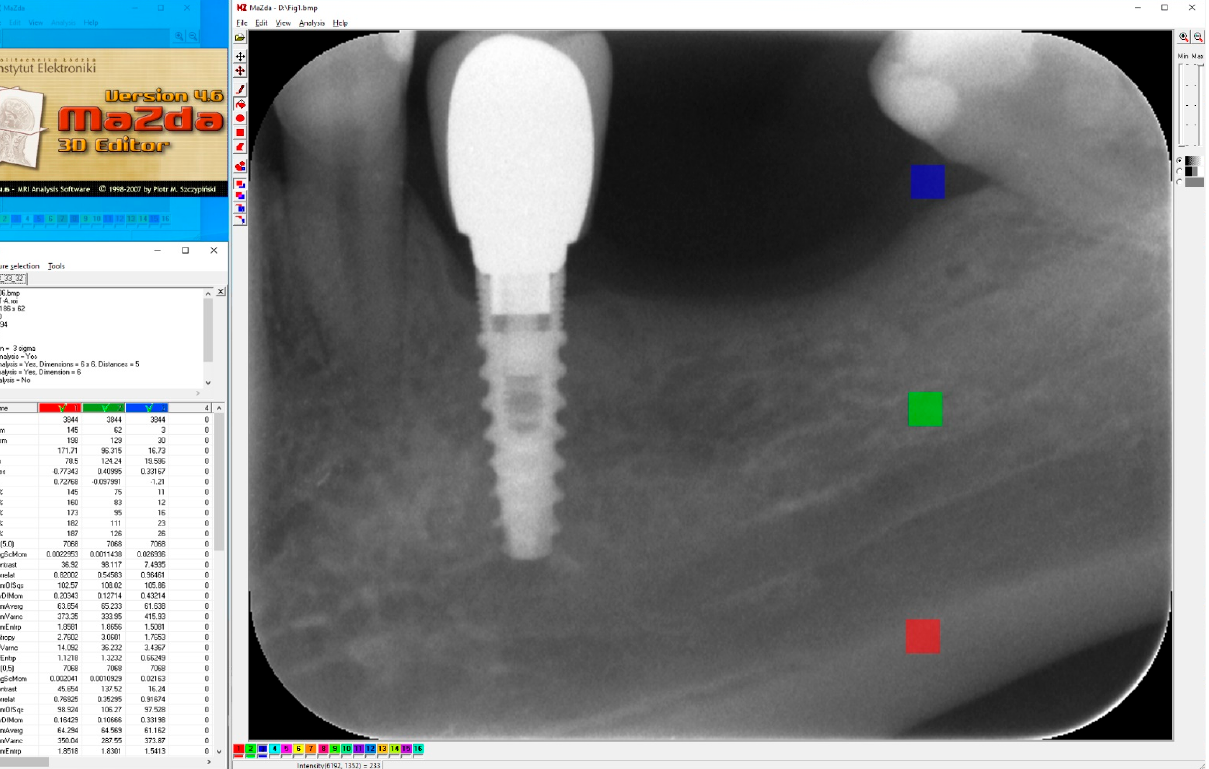
Figure 1. Regions of interest were located in cortical bone (ROI 1), trabecular bone (ROI 2) and soft tissue (ROI 3) in main window of MaZda. Next, a series of textural features was extracted (MZ Reports—on the left) and exported in comma-separated vector format (CSV).